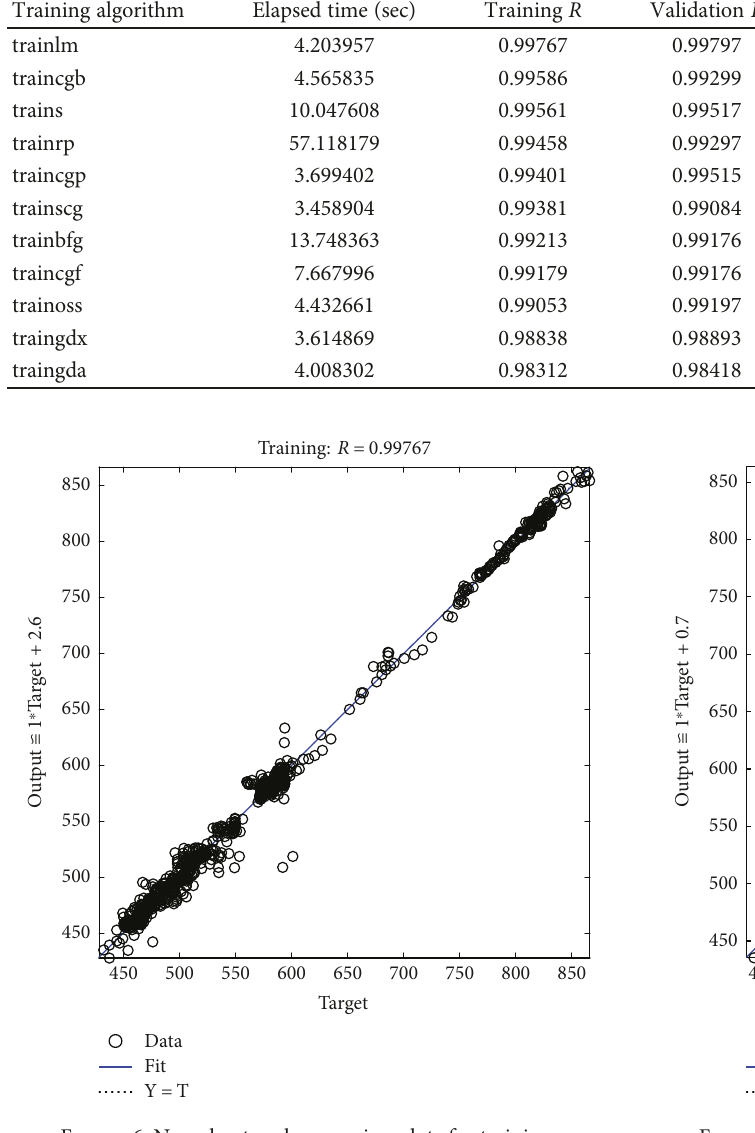
Figure 7: Neural network regression plots for validation. Figure 6: Neural network regression plots for